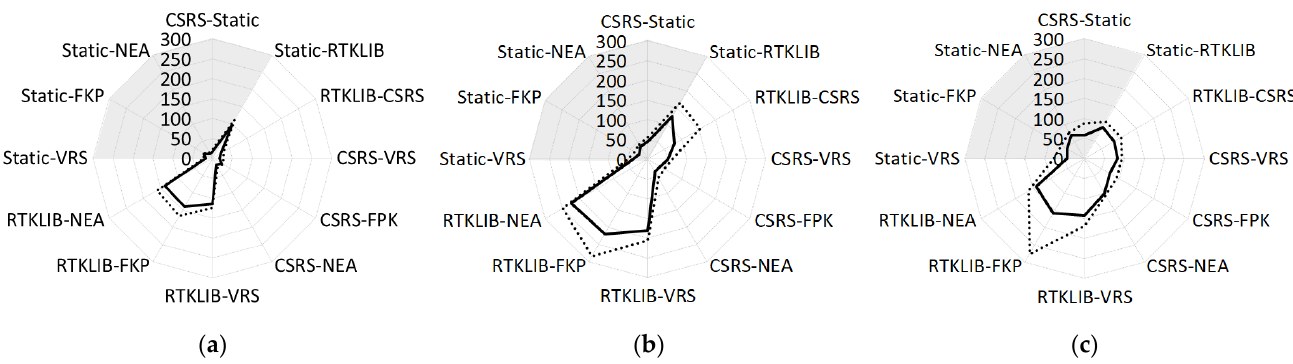
Figure 4. Standard deviation, σ (mm), of: ( a ) Δ N; ( b ) Δ E; ( c ) Δ h differences, pre and post outliers’ removal (dashed and continuous lines, respectively).